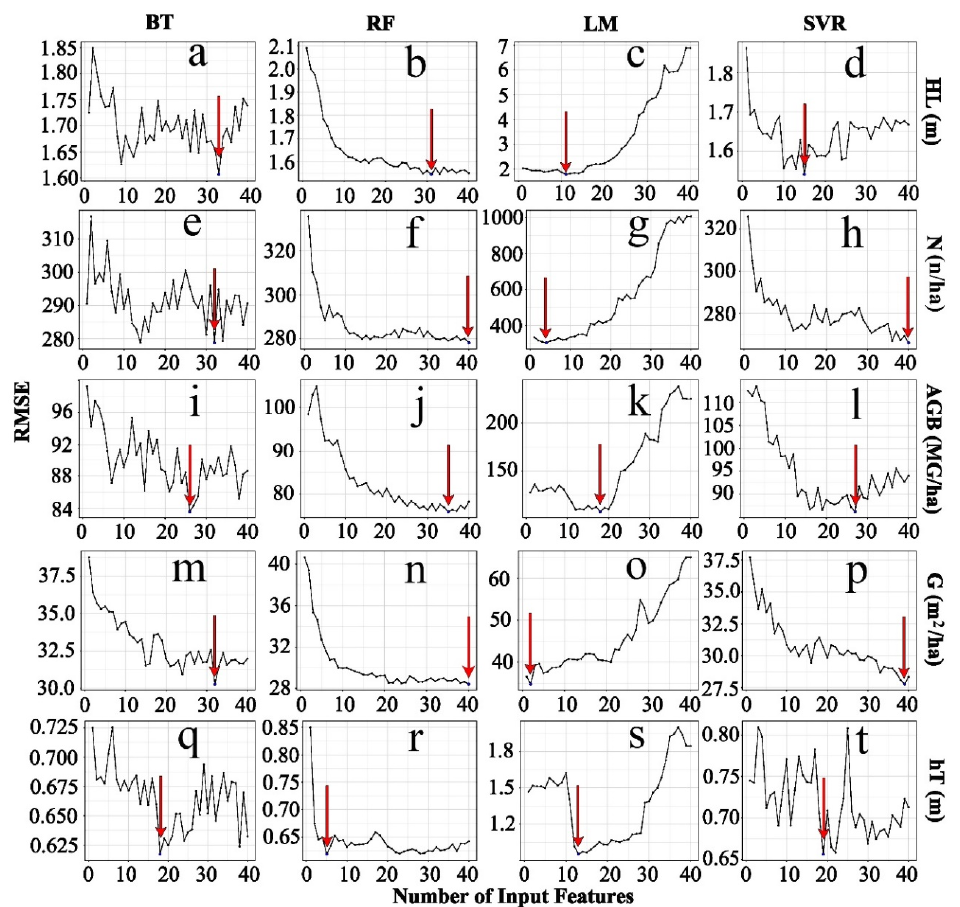
Figure 3. Effect of the subset feature size on the cross-validated root mean squared error recursive feature elimination (RMSE RFE ) for the forest structural parameters of canopy trees.